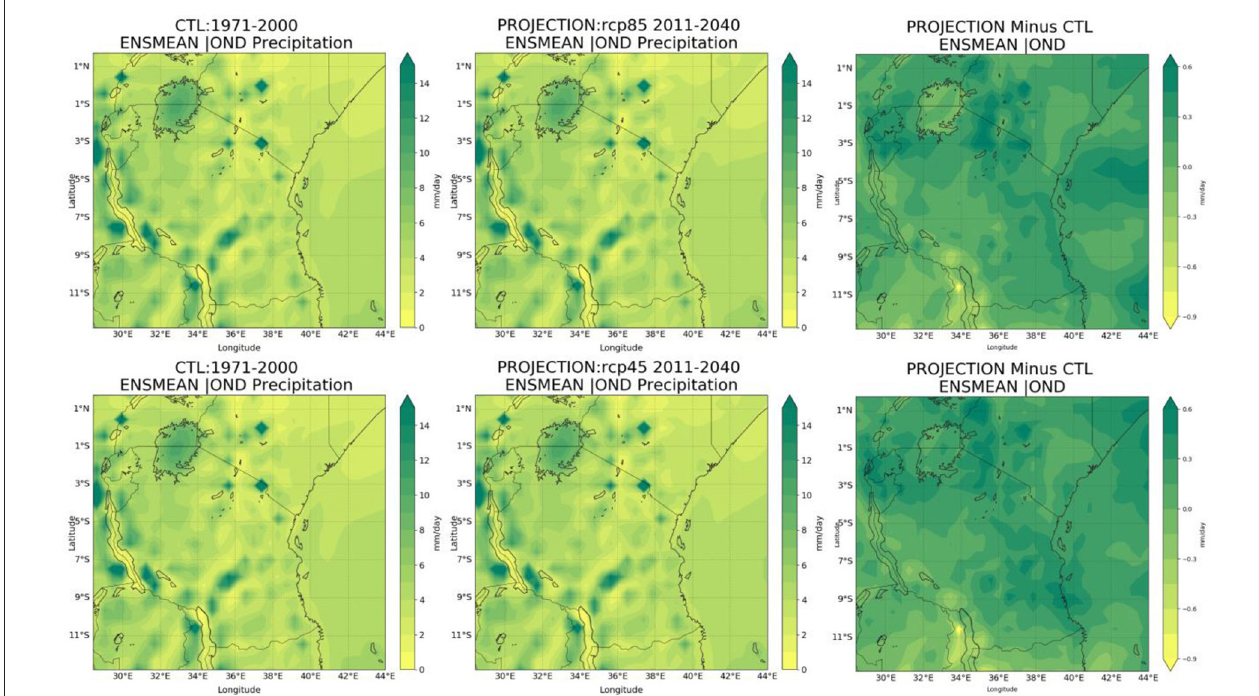
FIGURE 12 | Precipitation in mm/day for OND during base period (1971–2000), present century (2011–2040), and change in precipitation under both RCP8.5 (upper) and RCP 4.5 (lower) .